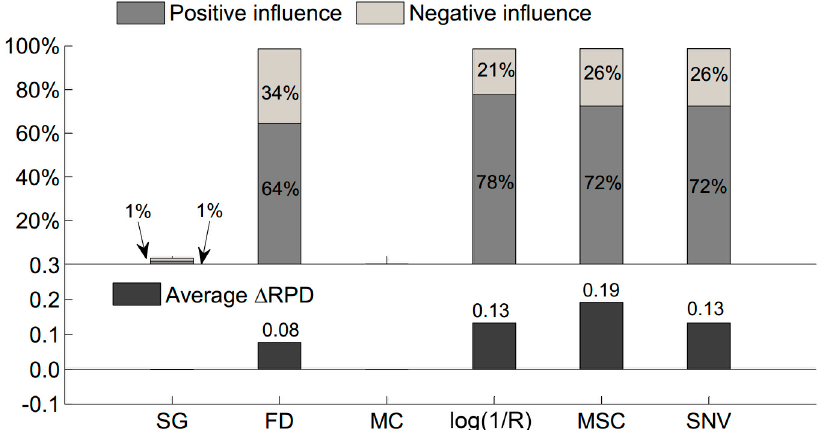
Figure 4. The results of the proportion of calibration sets when pretreatment influenced sample selection positively (dark gray bar) or negatively (light gray bar) and the average ∆RPD (black bar). SG denotes Savitzky–Golay smoothing. FD denotes first derivative. MC denotes mean centering. log(1/R) denotes logarithmic function. MSC denotes multiplicative scatter correction. SNV denotes standard normal variate.